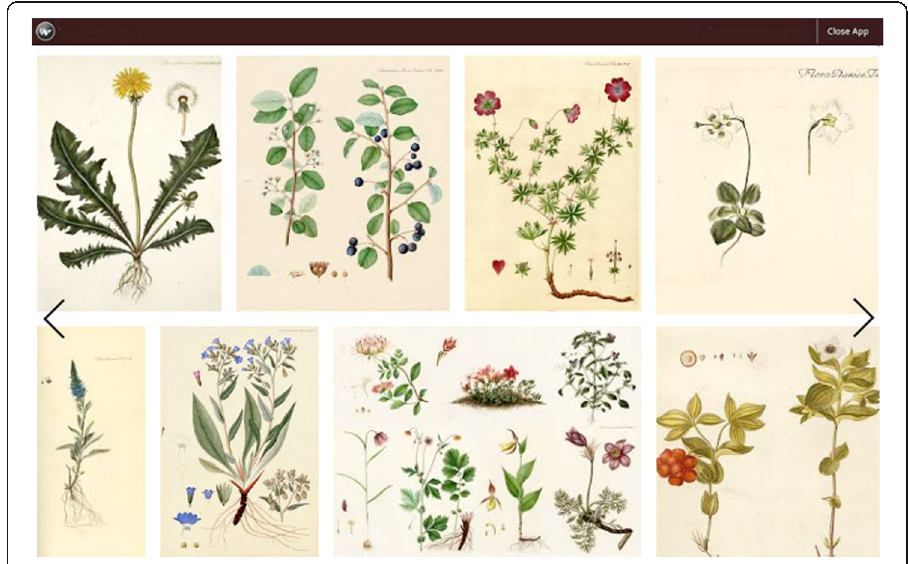
Fig. 1 An example of the first (exploration) stage where users are able to view the artifacts (paintings of plants in this case) by rotating a carousel of